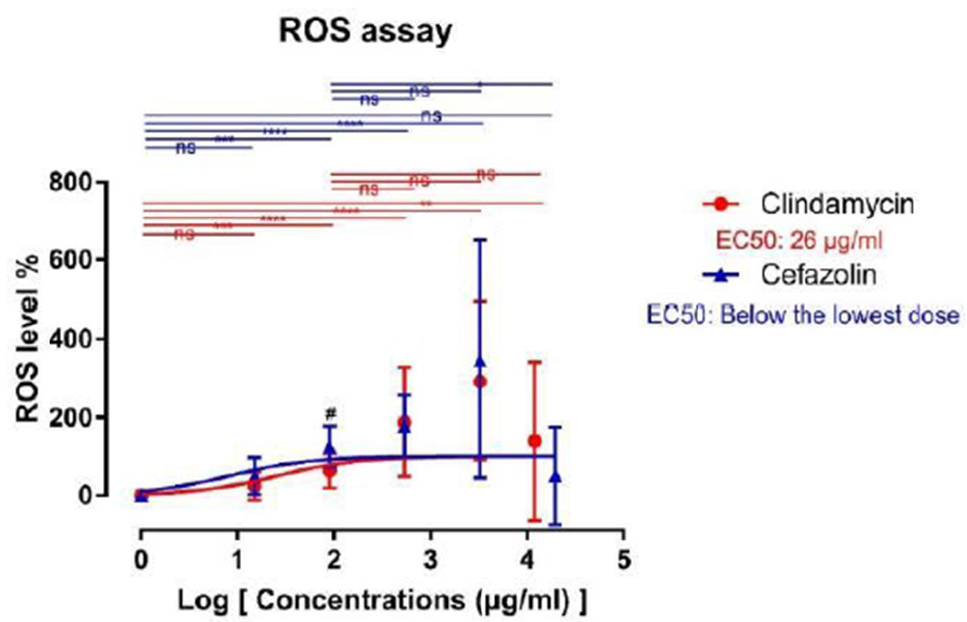
Figure 5. Sigmoidal dose-response curve for ROS assay. Data are shown as mean ± standard deviation. Asterix denotes statistically significant difference vs. the control group (ns = not significant; ** = p < 0.01, *** = p < 0.001, **** = p < 0.0001). Brackets indicate statistically significant differences between corresponding groups of clindamycin and cefazolin treated adipocytes (# = p < 0.05). ns means non-significant. EC50 characterizes the concentration leading to a 50% increase.